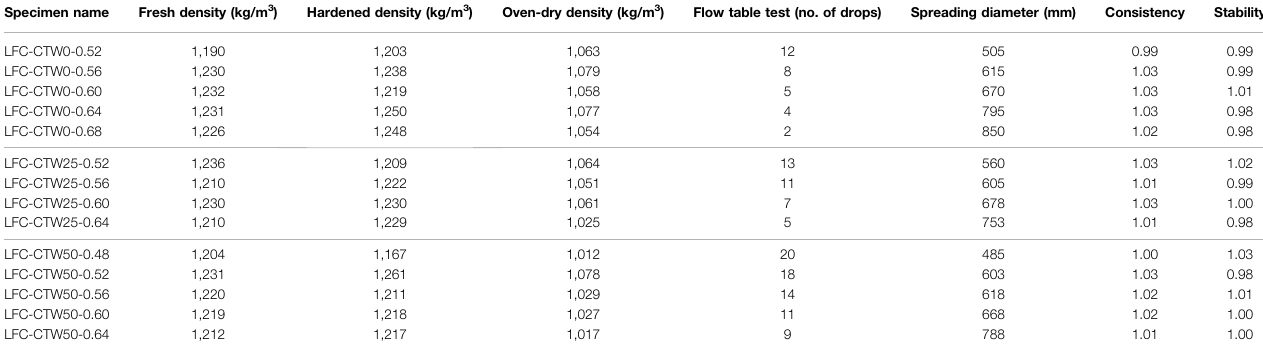
TABLE 3 | Fresh state properties of LFC-CTW0, LFC-CTW25, and LFC-CTW50 with various water-to-cement ratios. Specimen name Fresh density (kg/m 3 ) Hardened density (kg/m 3 ) Flow table test (no. of drops) Spreading diameter